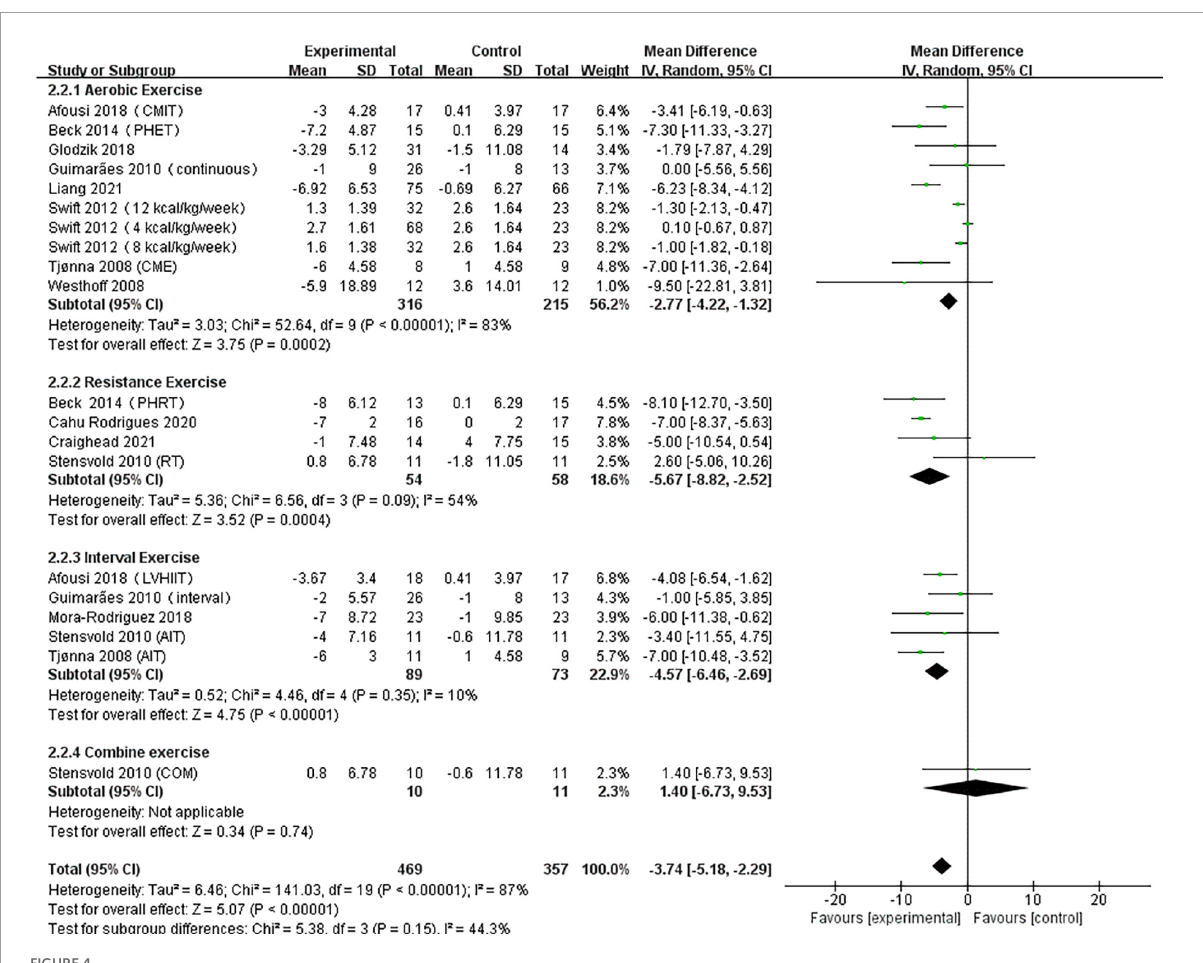
FIGURE4 Forest plot of postintervention DBP-value comparison between exercise and control groups. SD, standard deviation; Std, standardized; IV, inverse variance; CI, confidence